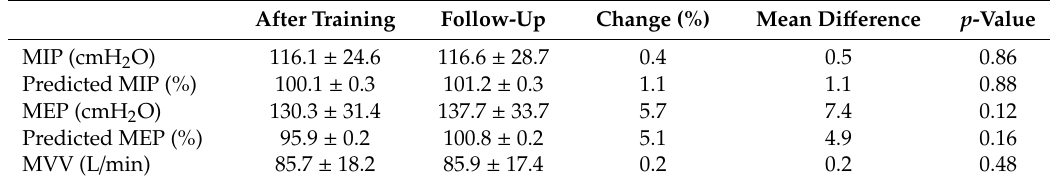
Table 4. Comparison of MIP, MEP, and MVV immediately after the program and six months after completion ( n = 15). Expressed as absolute and relative (percentage of predicted values) values. After Training